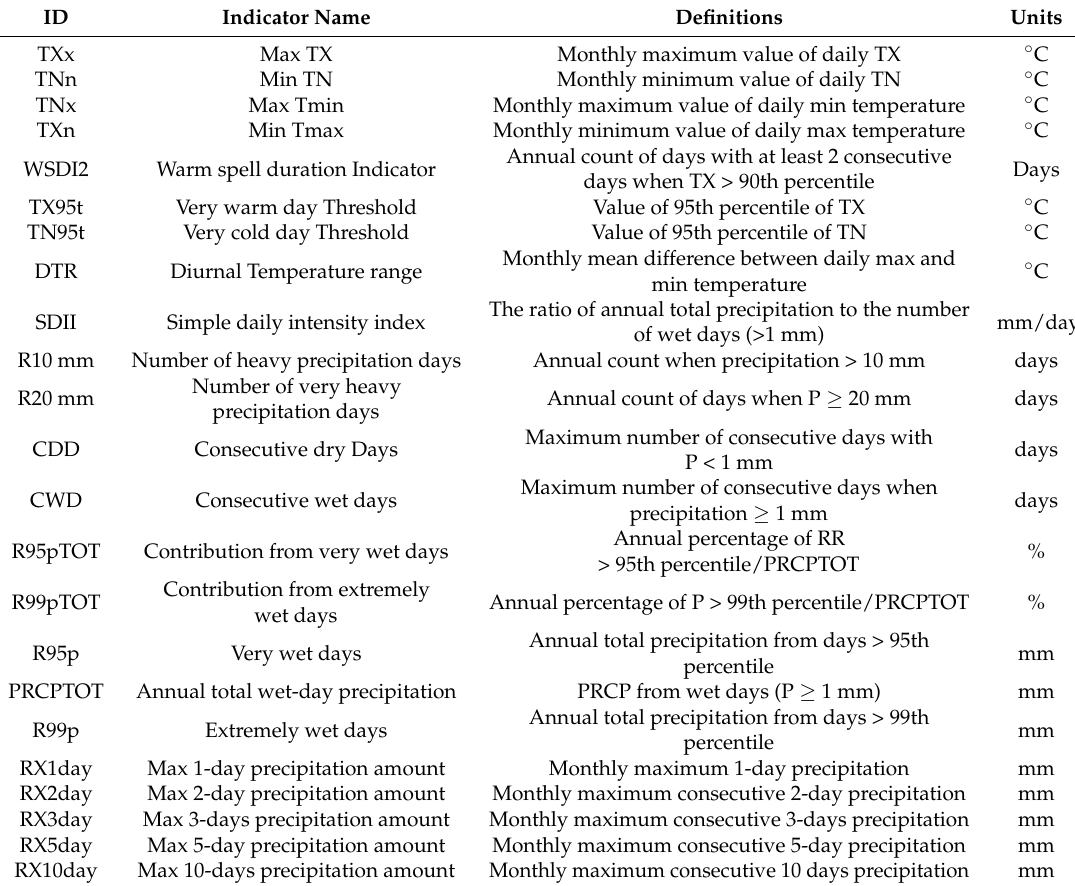
Table 2. Indices of Expert Team on Climate Risk and Sector-specific Indices (ET CRSCI) core indices where TN = minimum temperature and TX = maximum temperature, p = daily precipitation, and prcp = annual total precipitation